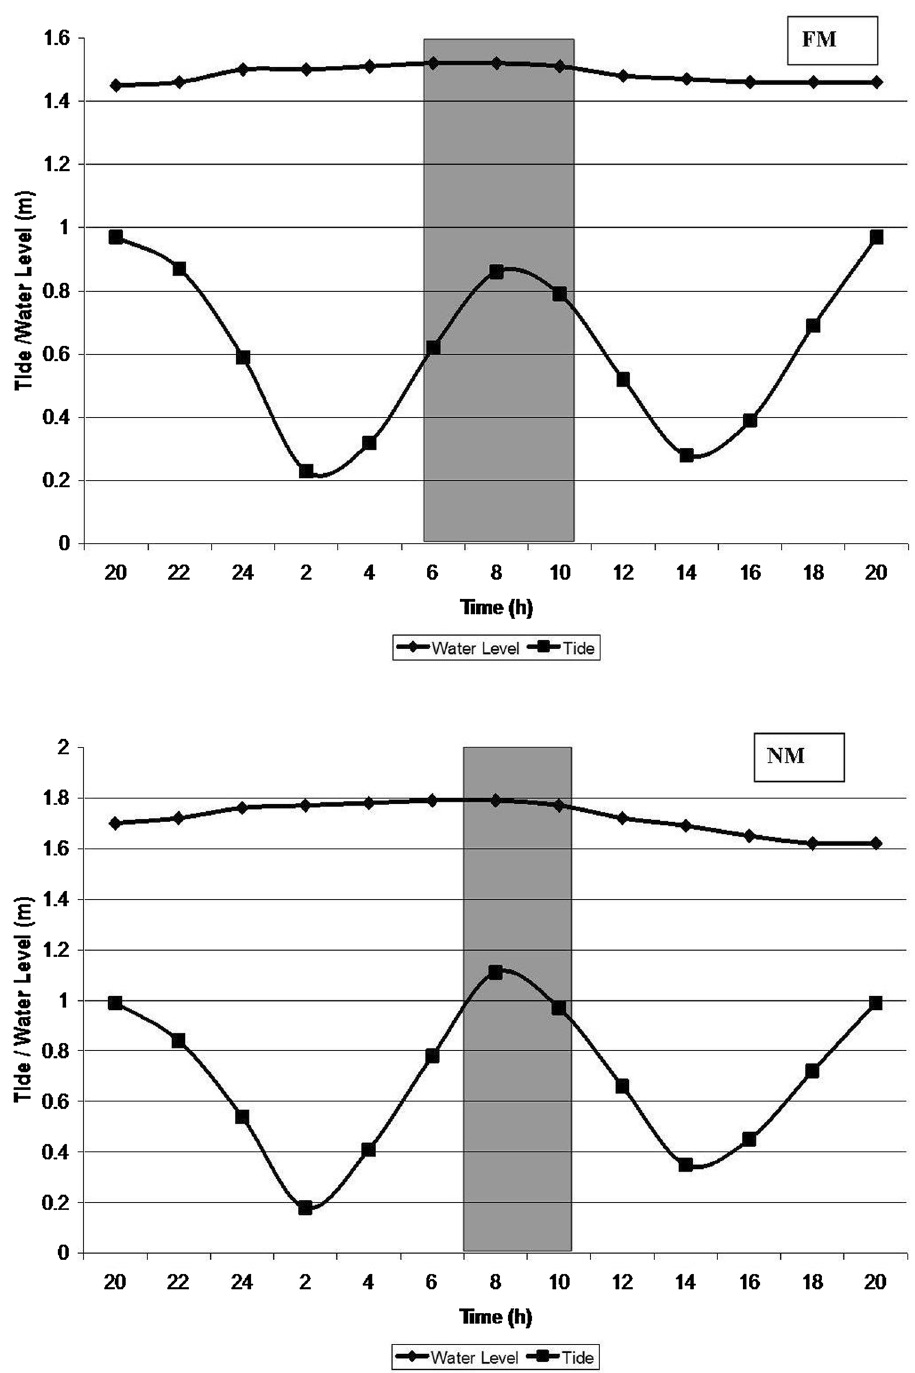
Fig. 6 Water level and Tidal Influence during FM and NM at Tiyagavalli